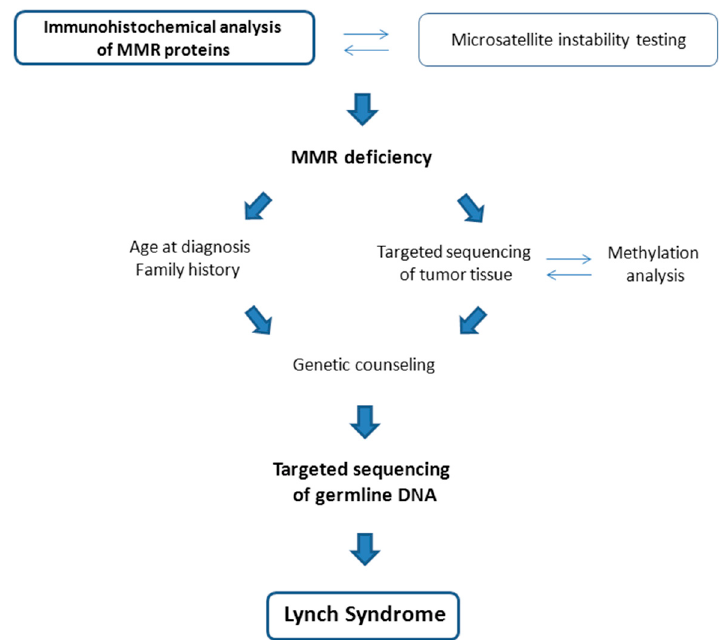
Figure 3. Paths to a Lynch Syndrome diagnosis, starting from the detection of MMR (mismatch repair) deficiency through IHC (immunohistochemical) or MSI (microsatellite instability) analysis. Patients with clinical criteria of Lynch Syndrome may be tested directly for germline predispositions (left arm). Targeted sequencing of MMR genes in tumor tissue, perhaps complemented by methylation analyses, may also reveal pathogenic variants that would qualify to be tested in the germline and may ultimately lead to a LS diagnosis (right arm).